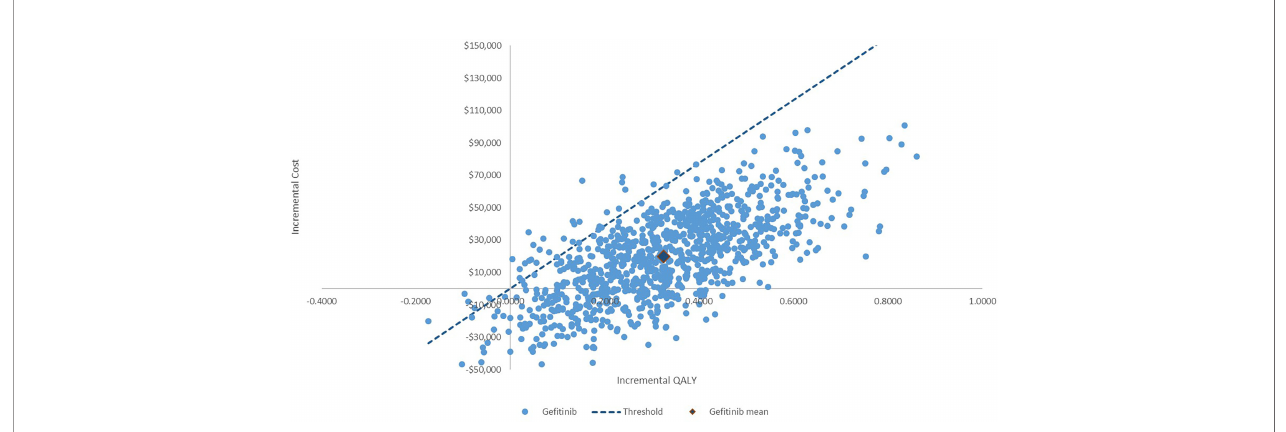
FIGURE 3 | Incremental cost-effectiveness plane: Dacomitinib vs. ge fi tinib. The probability of dacomitinib being cost-effective is 97%.